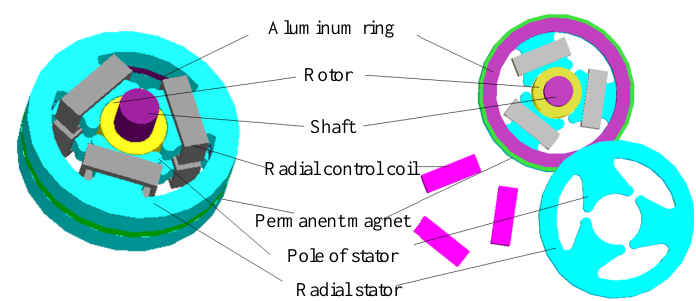
Figure 2. Configuration of radial AC HMB.